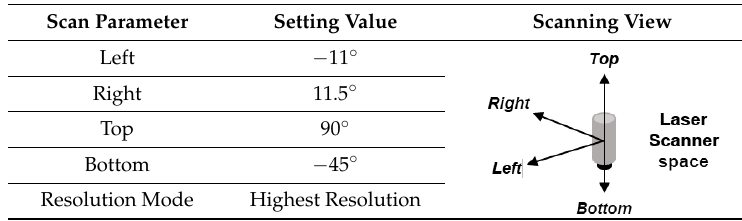
Table 4. Setting values of terrestrial laser scanner.